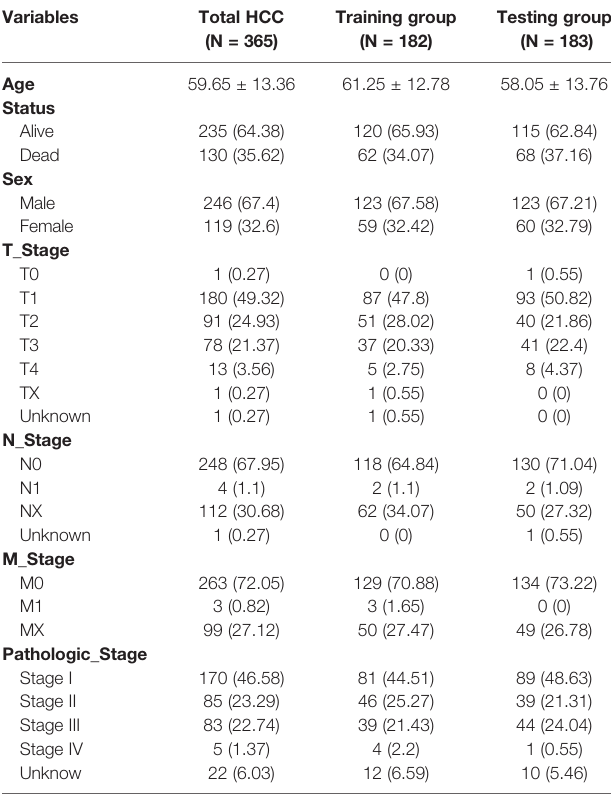
TABLE 1 | Clinical characteristics of the included HCC patients from TCGA-HCC. Variables